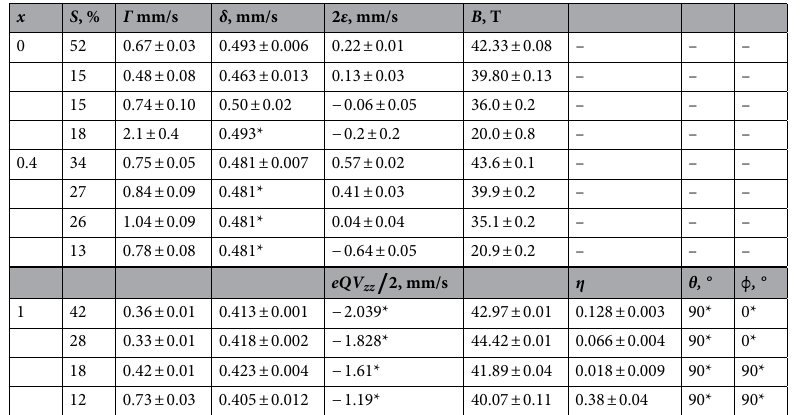
Table 3. Parameters of sextets and Hamiltonian used to fit to Y x Gd 1−x Mn 0.97 Fe 0.03 O 3 Mössbauer spectra measured at 11–12 K: S is relative area, Γ –linewidth, δ—isomer shift relatively to α-Fe at room temperature, 2 —term of quadrupole interaction, B —hyperfine field, η —asymmetry parameter, 2 ε —quadrupole shift, eQV zz θ is the angle between magnetization and EFG z axis and φ is the angle between magnetization projection and (cid:31) EFG x axis .